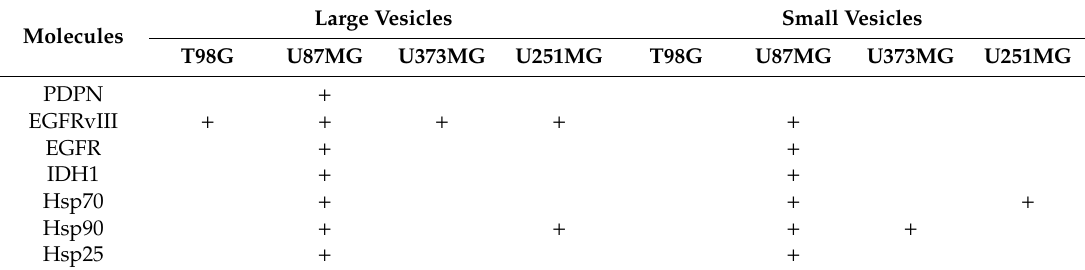
EGFR: epidermal growth factor receptor, EGFRvIII: epidermal growth factor receptor variant III, IDH1: isocitrate dehydrogenase 1, PDPN: podoplanin, Hsp25: heat shock protein 25, Hsp70: heat shock protein 70; Hsp90: heat shock protein 90. ( + ):